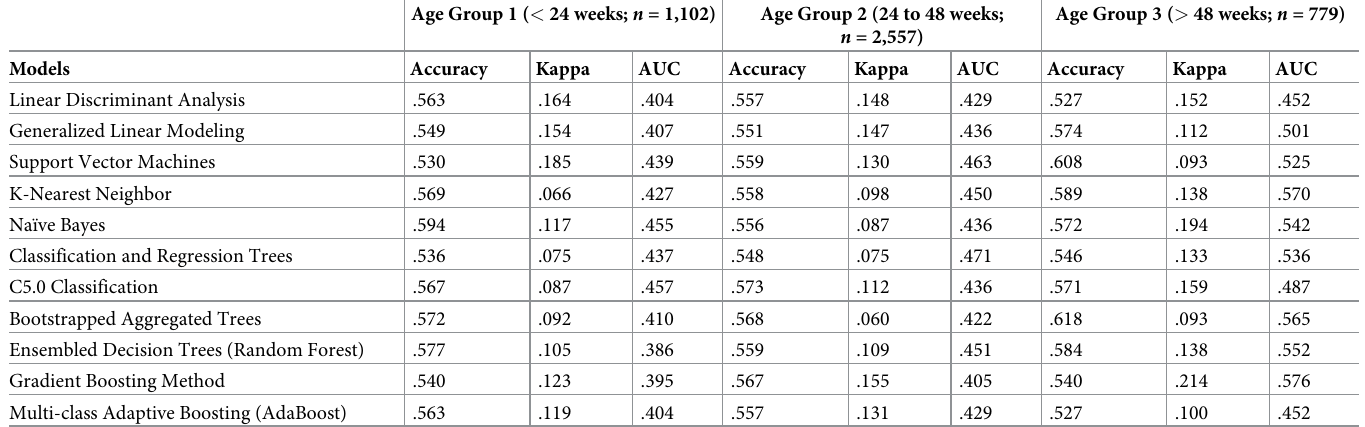
Table 3B. Classification effectiveness indicators across machine learning algorithms: Gender by age with temperament